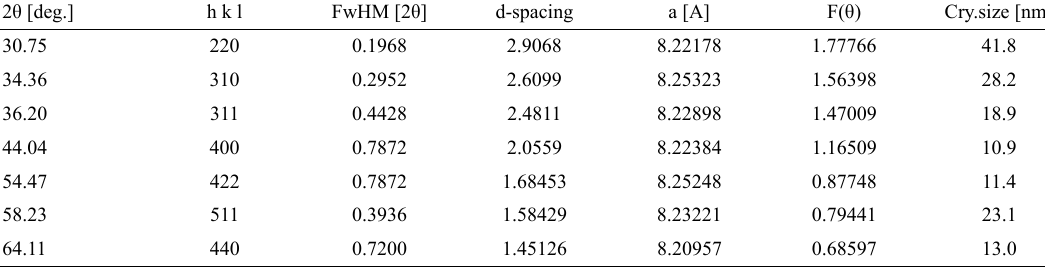
Table 2. Peak analysis of XRD pattern of synthesized Al-dopped CoFe 2θ [deg.]